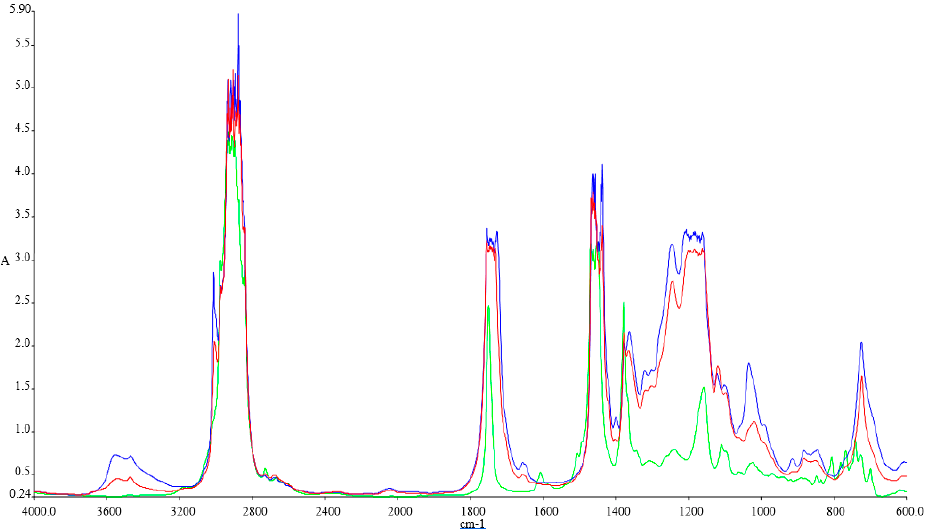
Figure 1. FTIR spectra of Green-Ke, Blue-SF, and Red-SFP.